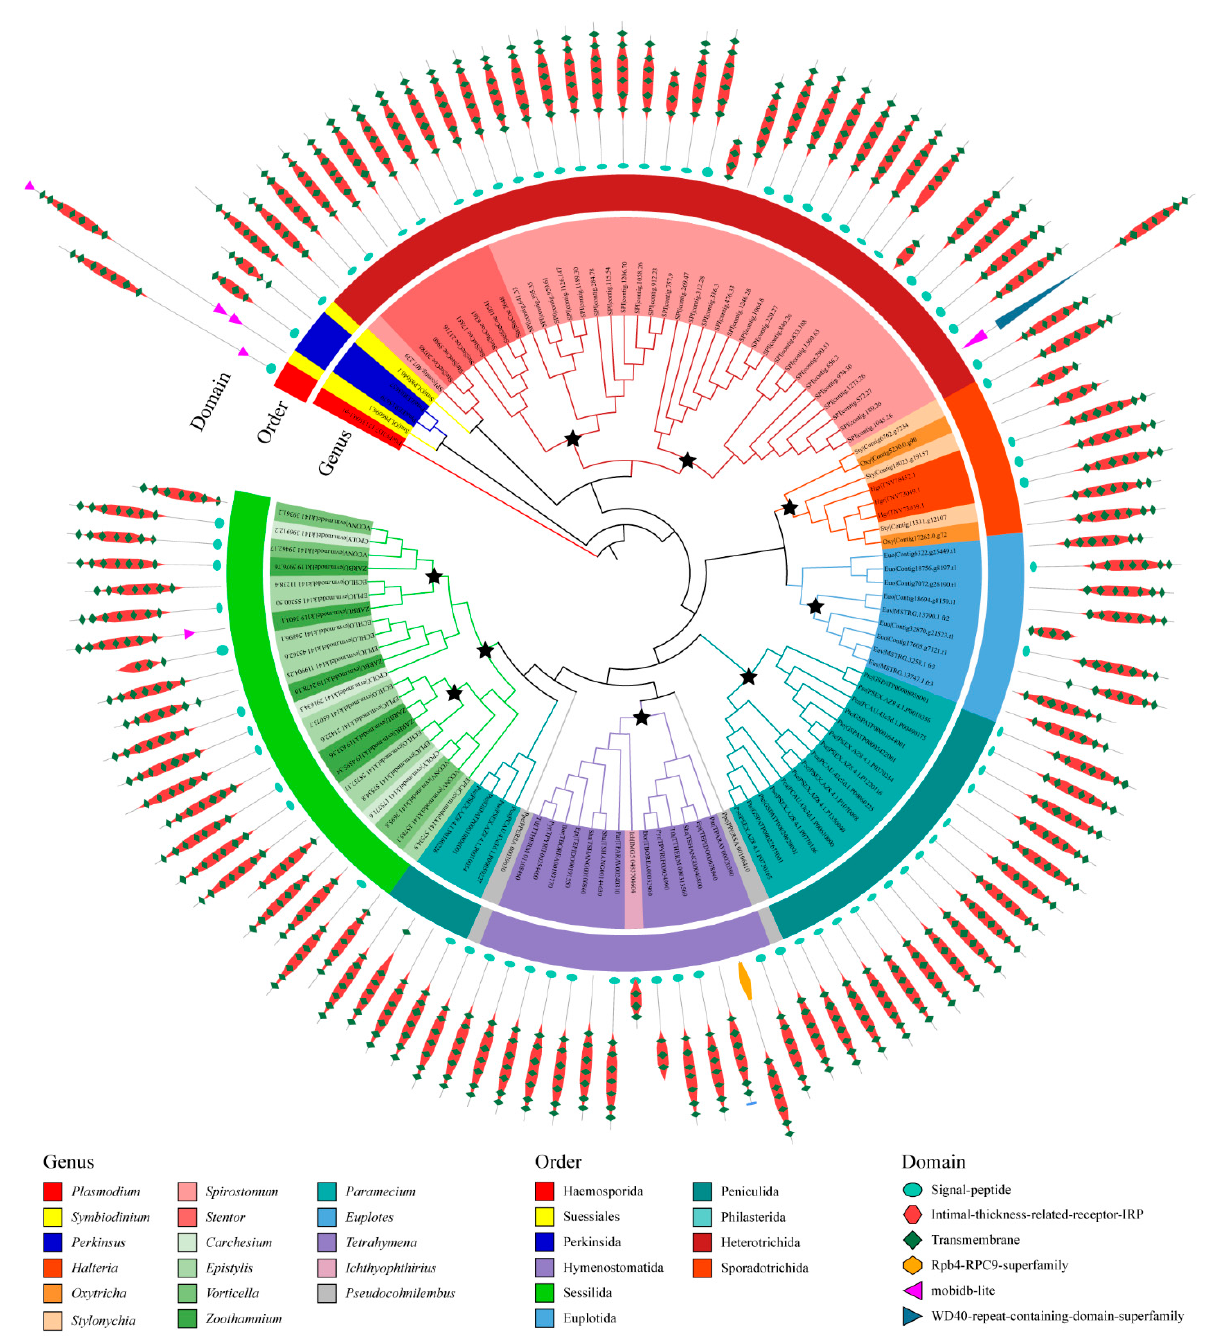
Figure 4. Phylogenetic tree of GPCRs in the most conserved ortholog group. Stars indicate the duplicate on events of GPCR